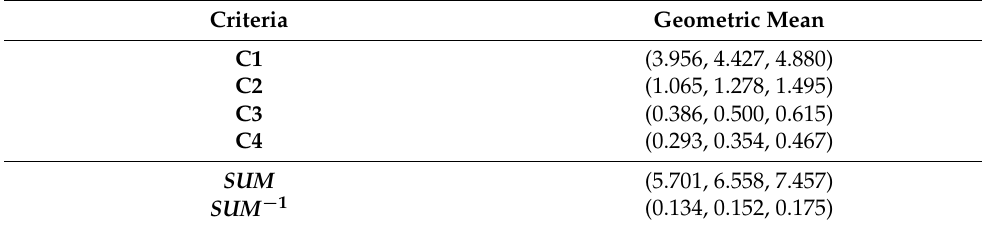
Table 10. Main criteria geometric mean.